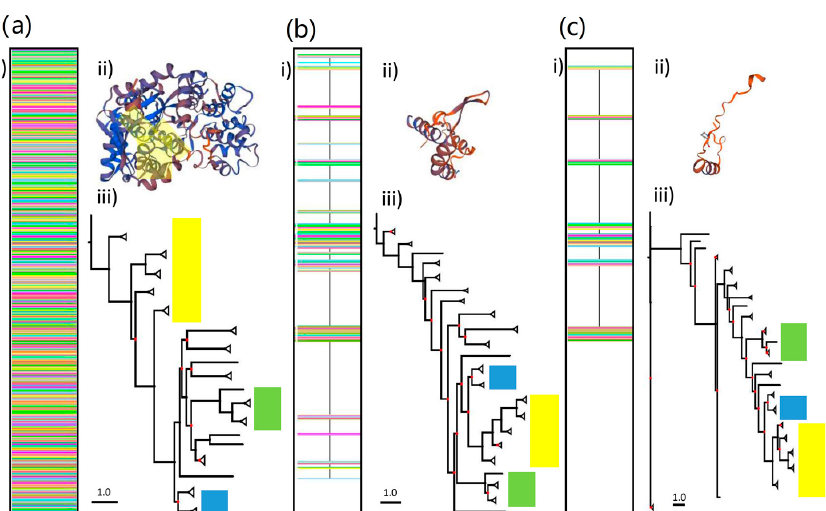
Figure 5. Alignment (i), protein structure homology-modelling analyses (ii) and maximum likelihood phylogenetic trees (iii) for ( a ) untrimmed, ( b ) trimmed-gappyout and ( c ) trimmed-strict amino acid sequences using YP_239361.1 (534 amino acid picobirnavirus genogroup 1 sequence). Scale bar corresponds to 1.0 substitutions per amino acid. Highlighted areas in a (ii) show protein structure regions retained in b and c. Highlighted regions in (iii) show the relative position of genera from Partitiviridae (yellow), Birnaviridae (green) and Picobirnaviridae (blue) families. Branch support values in trees are presented as coloured nodes (black >0.8, red <0.8).